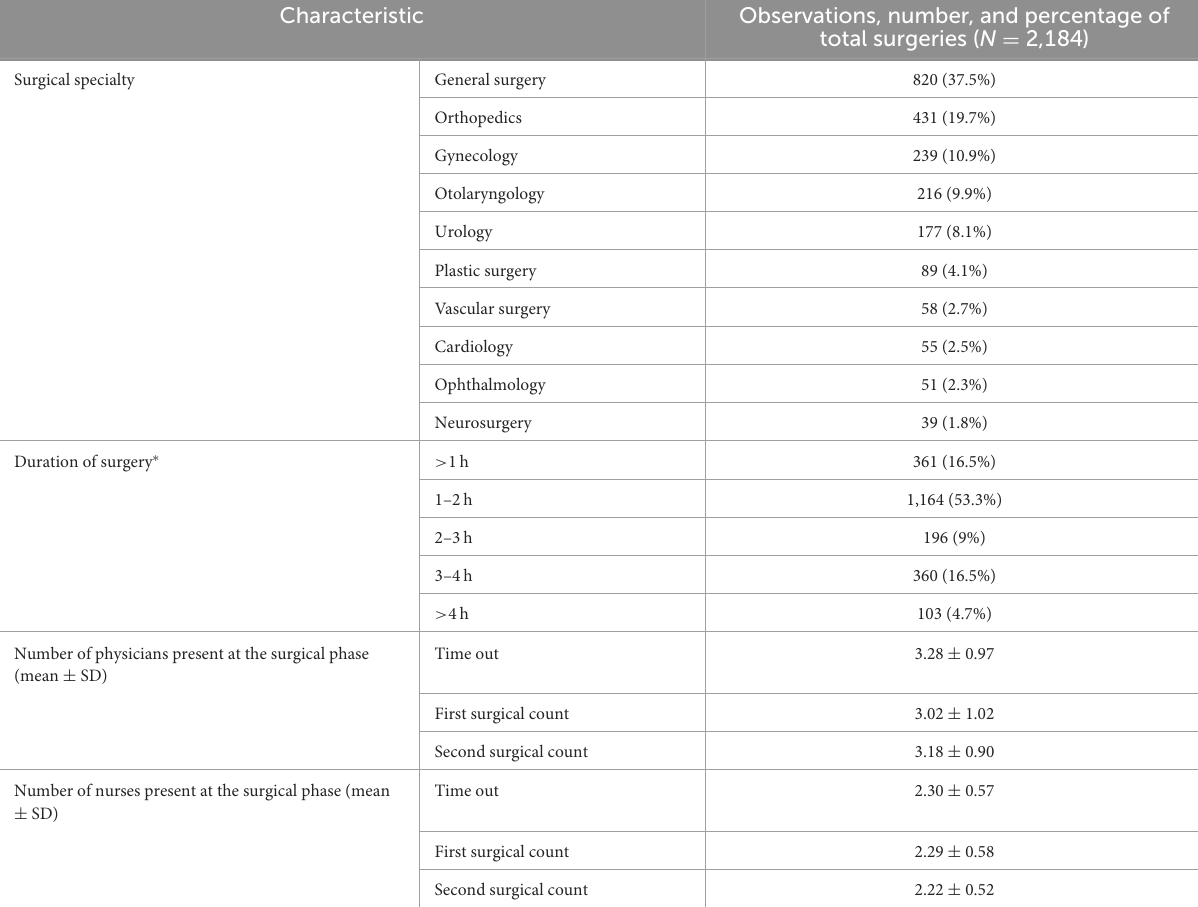
TABLE 1 Characteristics of surgeries observed.